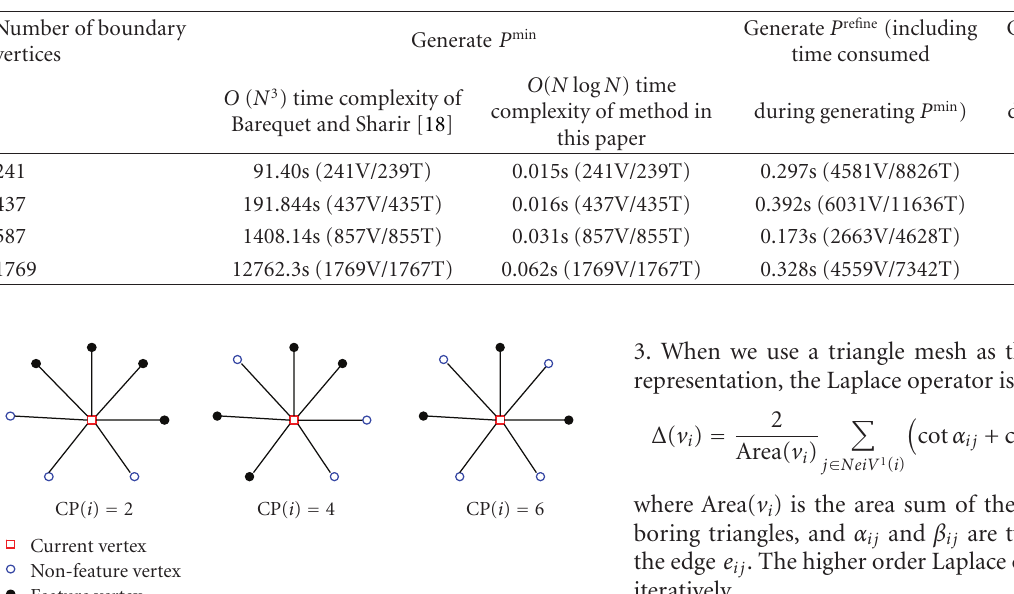
Table 2: Time consumption and number of vertices (V)/triangles (T) generated at di ff erent stages in shape restoration with C 1 continuity.